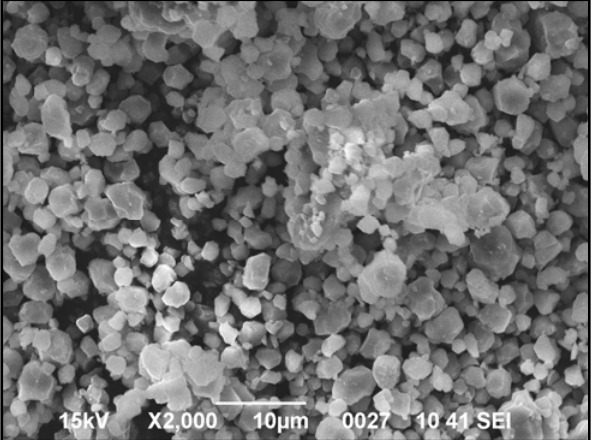
Figure 5. SEM image of (NH 4 ) 3 ScF 6 crystals obtained using ethanol at a ratio of 0.2.